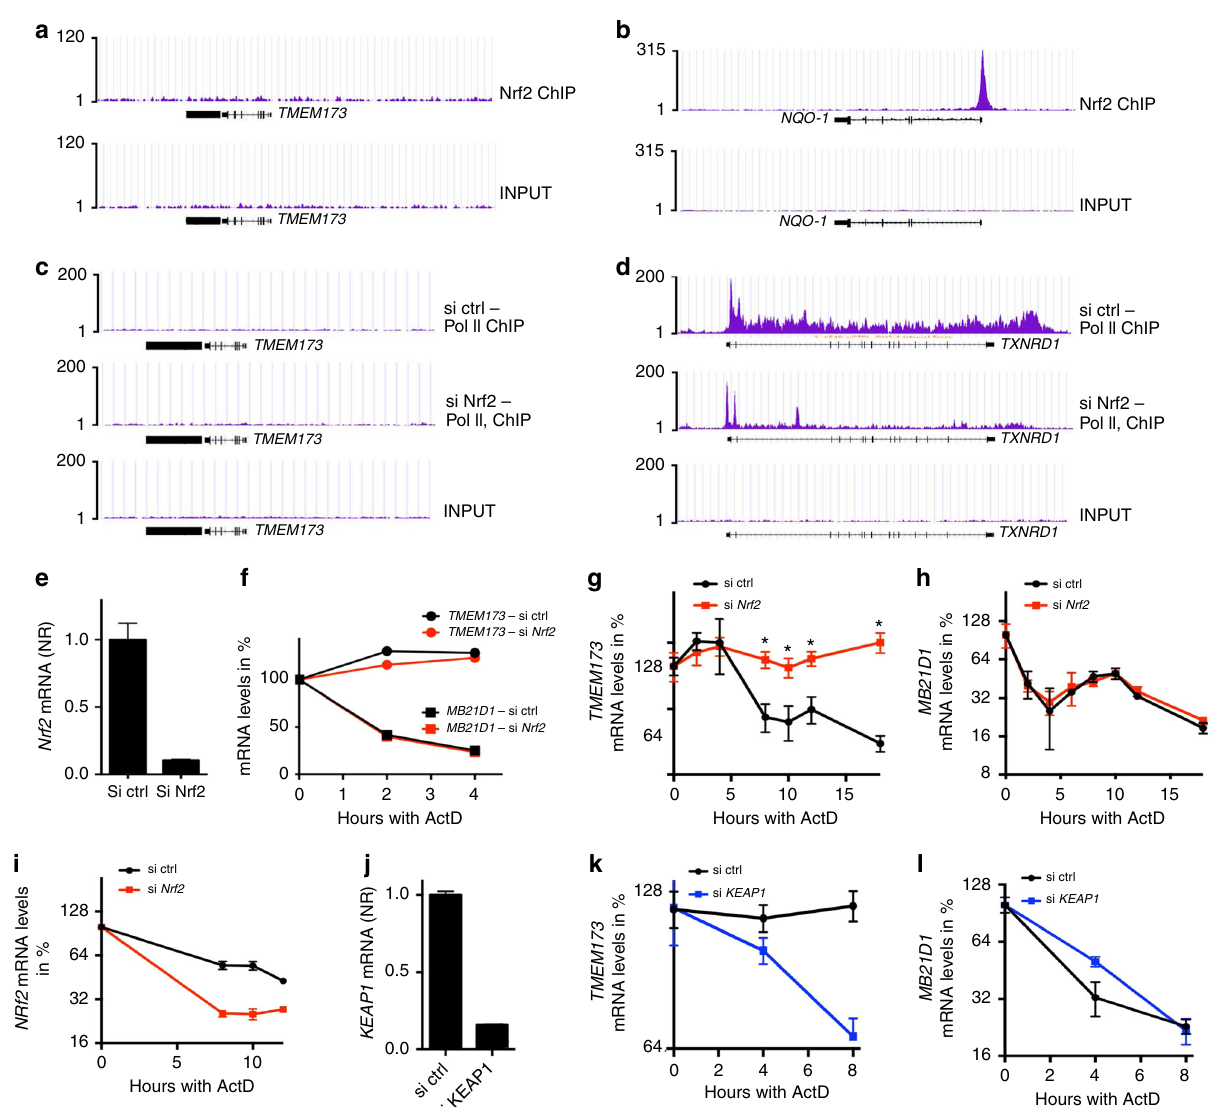
Fig. 2 Nrf2 regulates STING mRNA stability. a , b A549 cells were lysed and subjected to ChIP-seq using a Nrf2 speci fi c antibody. Graphs display fragment pileup per 1 million reads at the genomic loci proximal to TMEM173 ( a ) and NQO-1 ( b ). c , d A549 cells were treated with either control (ctrl) or Nrf2 targeted siRNA for 48 h. Cells were then lysed and subjected to ChIP-seq analysis using a Pol II-speci fi c antibody. Graphs display fragment pileup per 1 million reads at the genomic loci surrounding TMEM173 ( c ) and TXNRD1 ( d ). e – i A549 cells were treated with ctrl or Nrf2 siRNA for 48 h. Knockdown ef fi ciency of Nrf2 was determined by qPCR ( e ). f – i Cells were then treated with Actinomycin D (10 µ g/mL) as indicated and gene expression was determined by qPCR. The graph in ( f ) is one representative of two independent experiments. The graphs in ( g ) and h contains merged data from two independent experiments with n = 5 at the 8 h timepoint and n > 2 for remaining time points. Data displayed in ( i ) represent one experiment with n = 3. (*) indicates statistical signi fi cance using Student ’ s t -test with p < 0.05. j – l HaCat cells were treated with ctrl or Keap1 siRNA for 72 h. Knockdown ef fi ciency of Keap1 was determined by qPCR ( j ). k , l Cells were then treated with Actinomycin D (5 µ g/mL) as indicated and gene expression was determined by